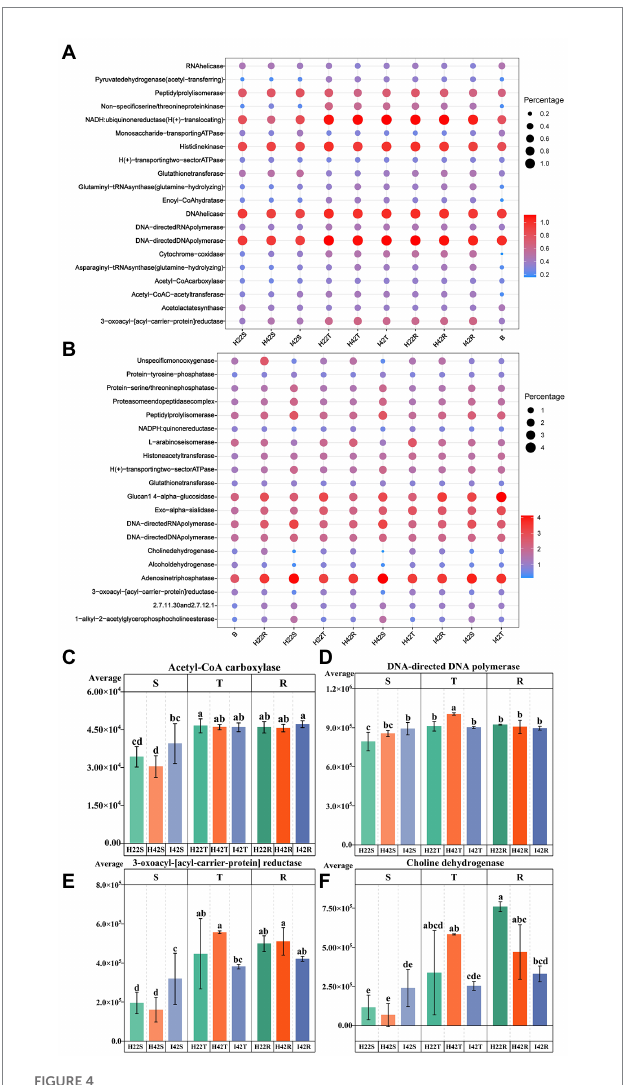
FIGURE 4 Annotated statistical heatmap of the microbiome function and histogram of the presence of functional differences. The X-axis of the graph represents the mean value of each subgroup, the Y-axis represents the main function obtained from the annotation, the size of the circle represents the abundance of the function and the color represents the correlation coefficient (r). (A) Functional annotated bubble diagram of the microbiome of each subgroup of bacteria. (B) Functional annotated bubble diagram of the microbiome of each subgroup of fungal. (C–F) Microbiome functions that showed the expected significant level of difference in resistance associated with different experimental subgroups. Error bars indicate standard deviation (+/–SD) and letters indicate differences between each subgroup. Differences were significant at the p ≤ 0.05 level calculated using the chi-squared test